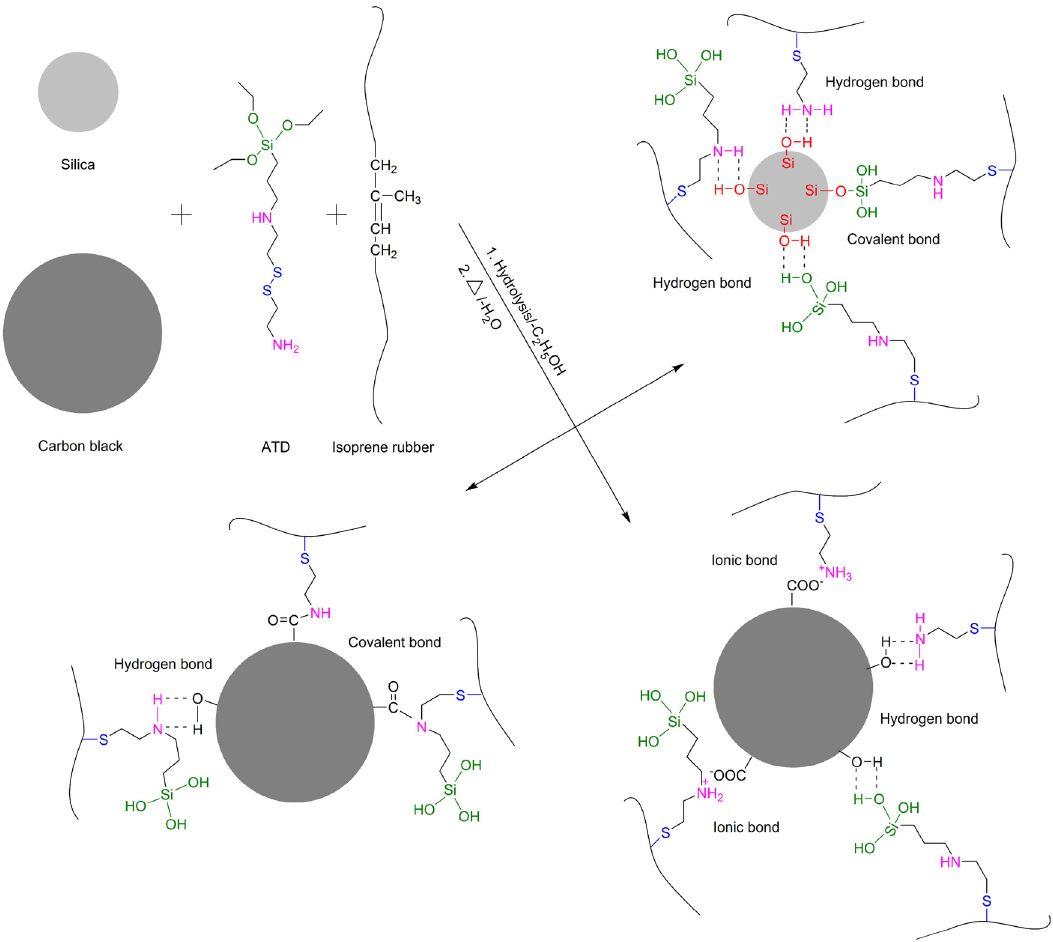
Figure 1: Postulated reactions of ATD toward rubber and fi llers of silica and